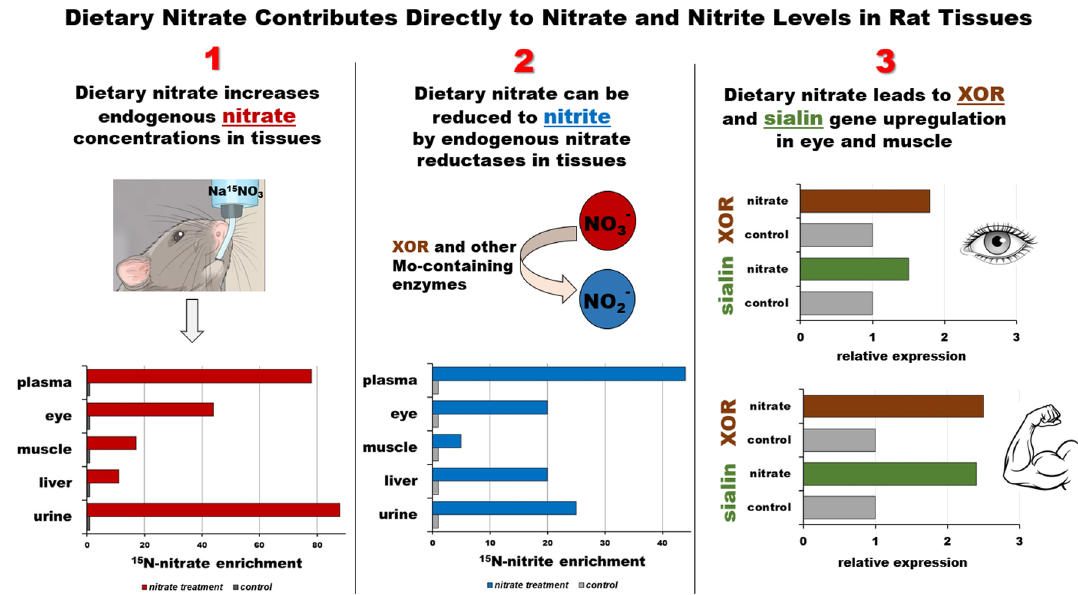
Figure 6. Effects of dietary nitrate supplementation on distribution of nitrate and nitrite ions and gene expression levels in tissues. 1: Na 15 NO 3 (1 g/L) supplementation for 3 days via drinking water lead to significant increases of 15 N nitrate contents in rat tissues and plasma. Unabsorbed 15 N nitrate is excreted in the urine. 2: Endogenous nitrate reductases, such as XOR, can reduce 15 N nitrate to 15 N nitrite in tissues and cause a rise in 15 N nitrite concentrations. Other Mo-containing enzymes include aldehyde oxidase (AO), sulfite oxidase (SO) and mitochondrial amidoxime reducing component (mARC). 3: Na 15 NO 3 (1 g/L) supplementation for 3 days induced an upregulation of nitrate transporter (Sialin) and nitrate reductase (XOR) genes in eye and gluteus